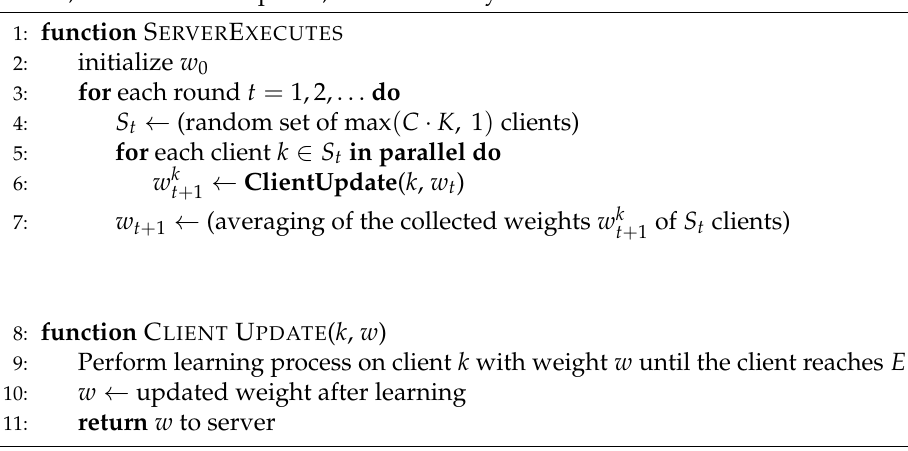
Algorithm 1 FederatedAveraging ( FedAvg ) algorithm (simplified from [5]); K = number of